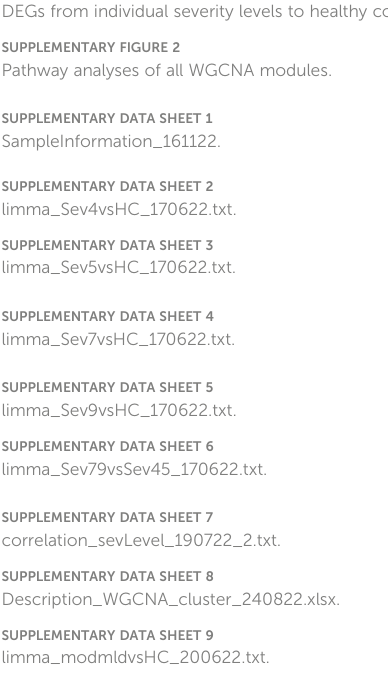
SUPPLEMENTARY FIGURE 2 Pathway analyses of all WGCNA modules. SUPPLEMENTARY DATA SHEET 1